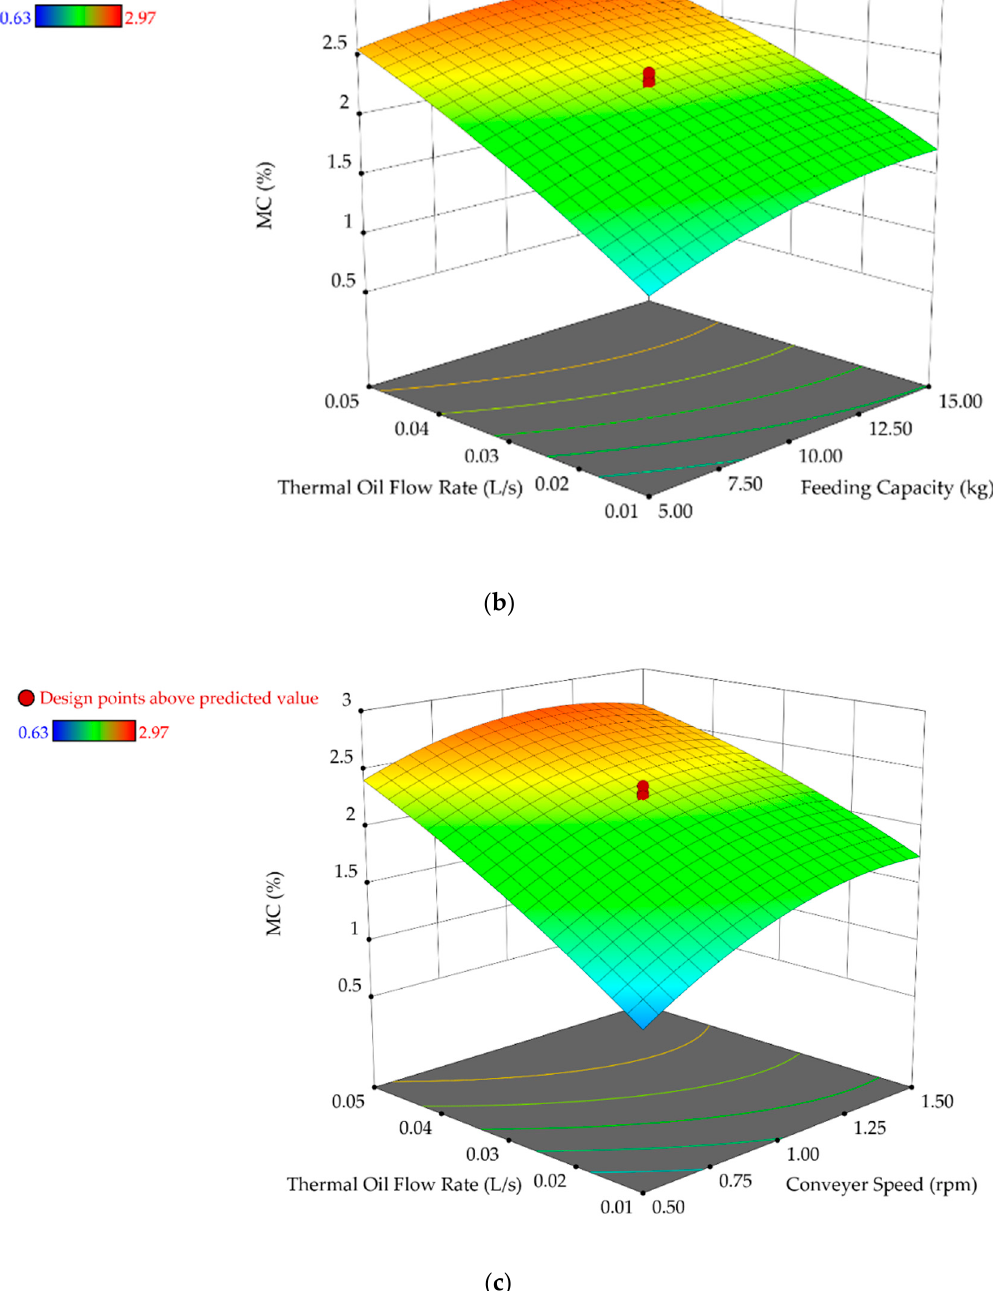
Figure 3. ( a ) Interactive effect of conveyor speed and feeding capacity on MC. ( b ) Interactive effect of thermal oil flow rate and feeding capacity on MC. ( c ). Interactive e ff ect of thermal oil flow rate and thermal oil flow rate and feeding capacity on MC. ( c ). Interactive effect of thermal oil flow rate and conveyor speed on conveyor speed on MC.